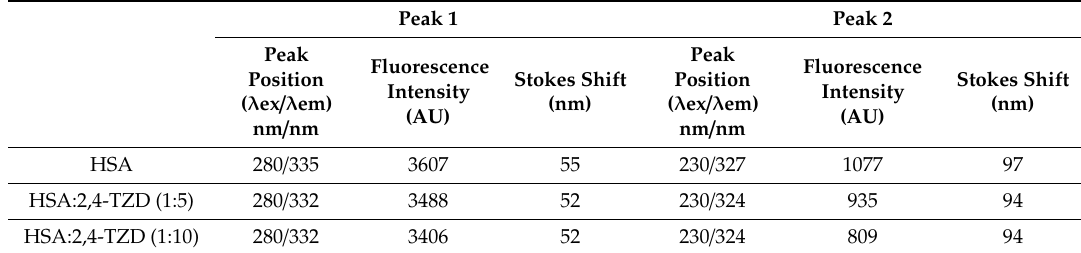
Table 5. 3D fluorescence parameters for the interaction between HSA and